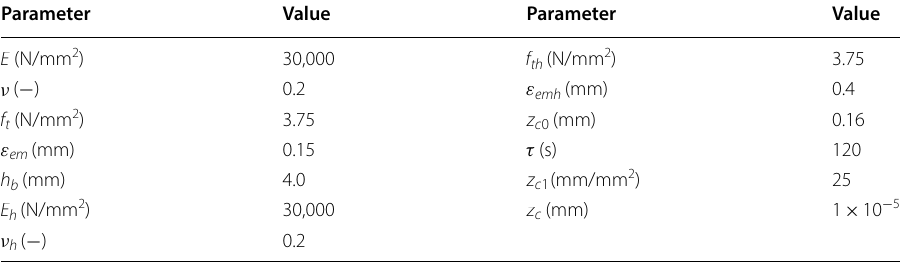
Table 2 Model parameters direct tension